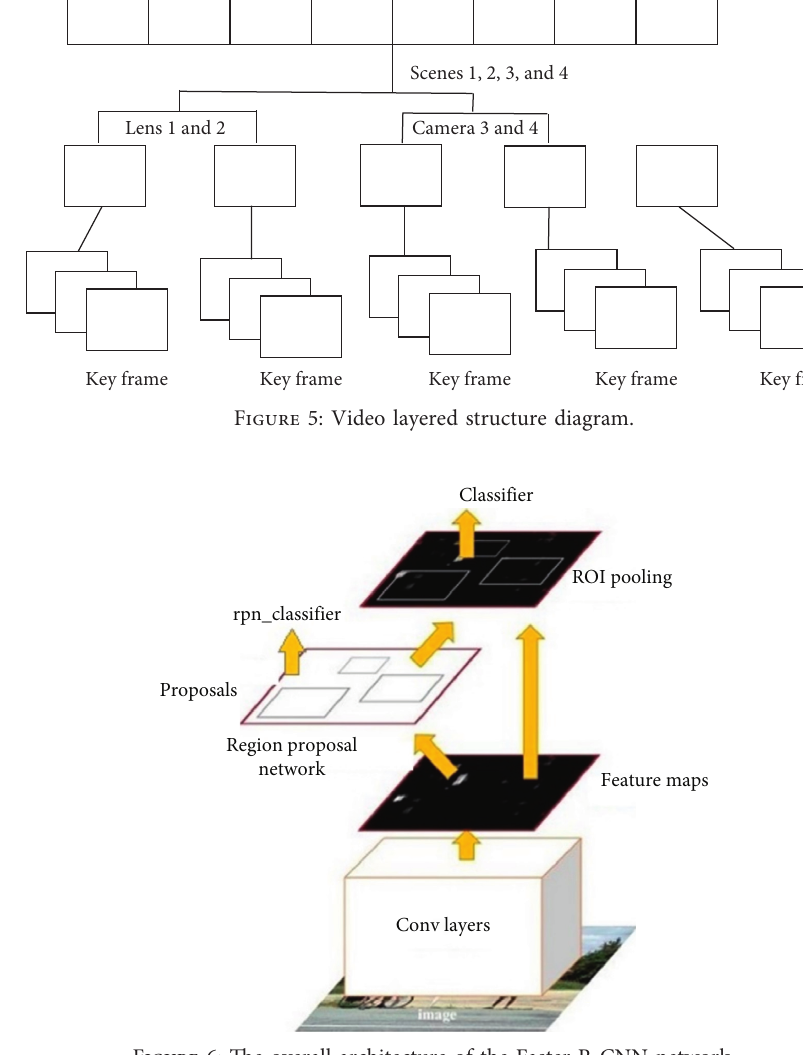
Figure 6: The overall architecture of the Faster R-CNN